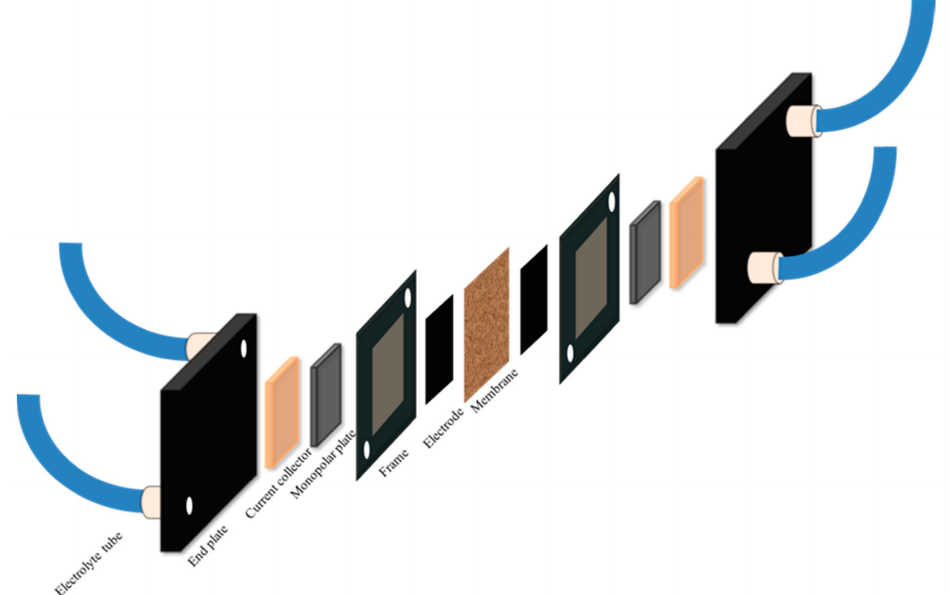
Figure 3. The configuration of vanadium redox flow battery single